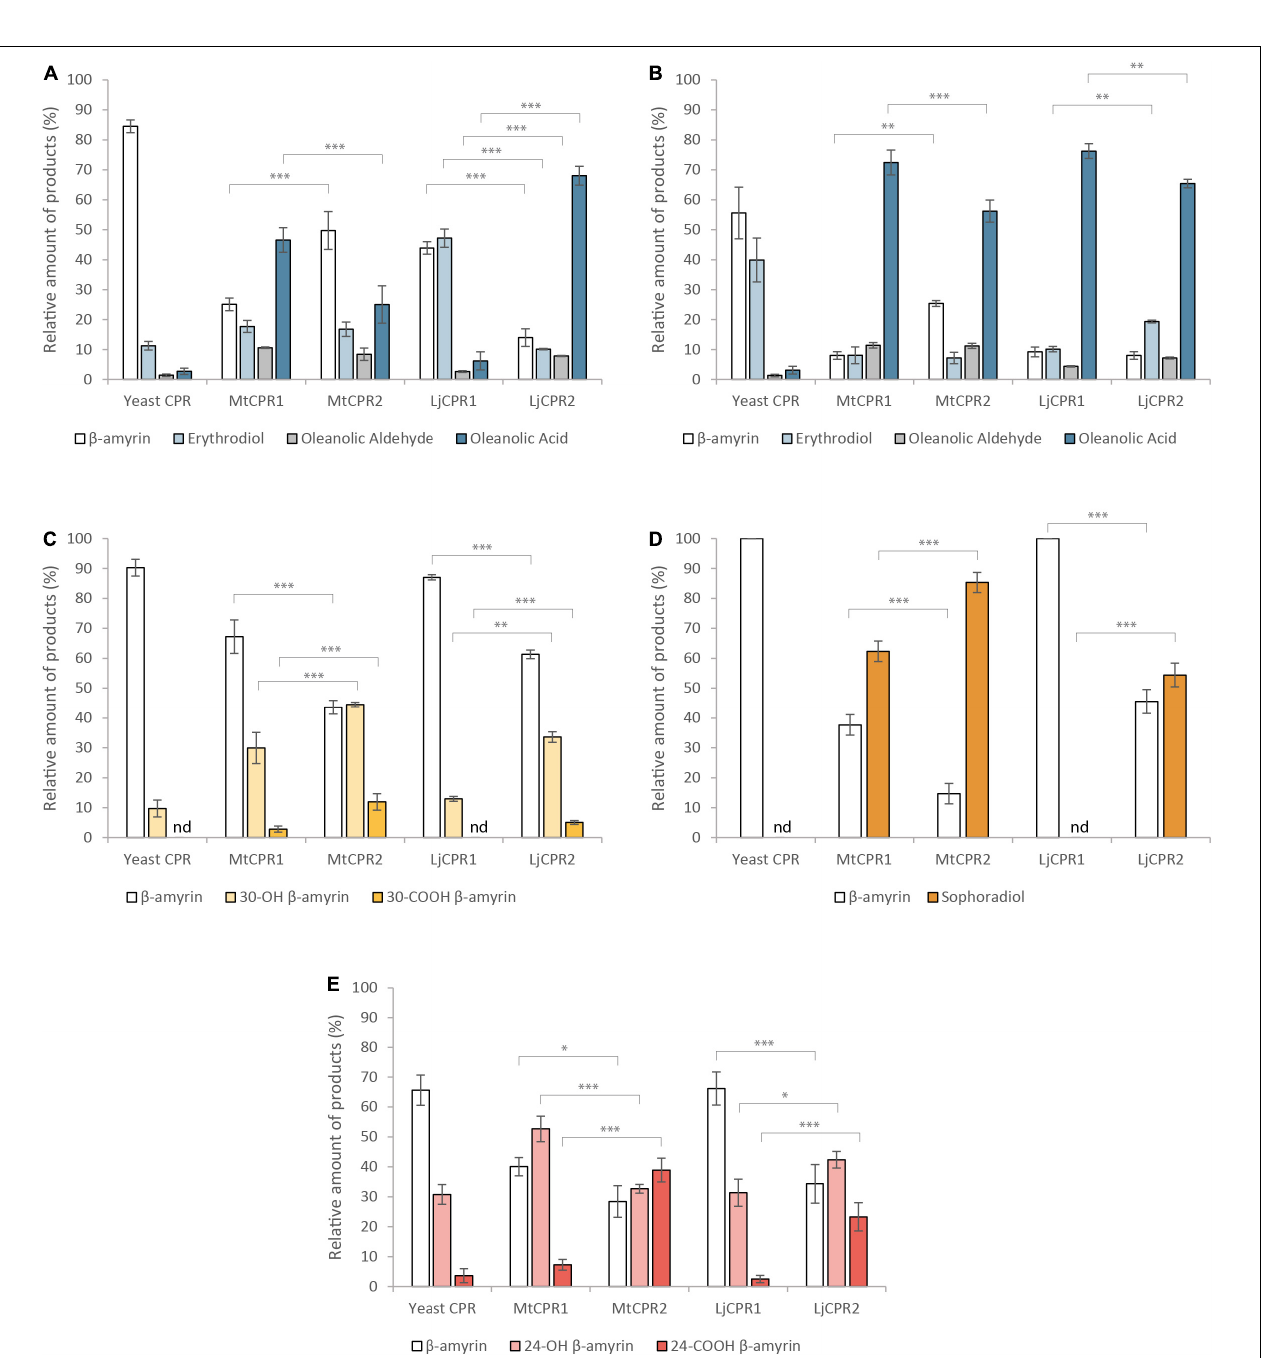
FIGURE 6 | The relative amount of triterpenoid produced using different combinations of CYPs and CPRs from M. truncatula and L. japonicus in β -amyrin-producing yeast (INV Sc1 strain). Triterpenoid profiles from (A) MtCYP716A12, (B) LjCYP716A51, (C) MtCYP72A63, (D) LjCYP72A61, and (E) LjCYP93E1 co-expressed with different CPRs in INV Sc1 . Triterpenoids content were measured relative to uvaol as internal standard. Data have been presented as mean ± SE ( n = 3). nd, signal below detection limit. Single-factor ANOVA was used for statistical comparisons. Values were considered statistically significant at * P < 0.05, ** P < 0.01, and *** P <